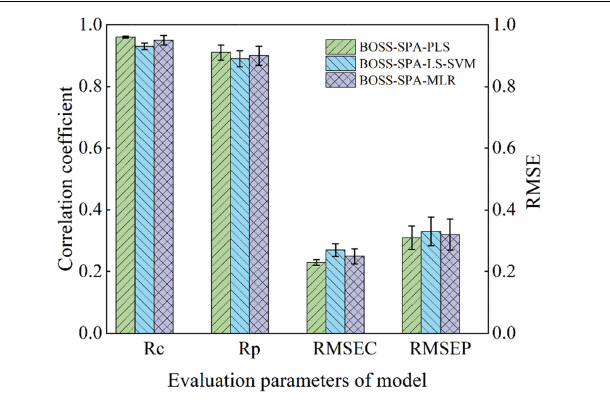
FIGURE 4 | Results of 20 predictions for BOSS-SPA-PLS, BOSS-SPA-LS-SVM, and BOSS-SPA-MLR models.